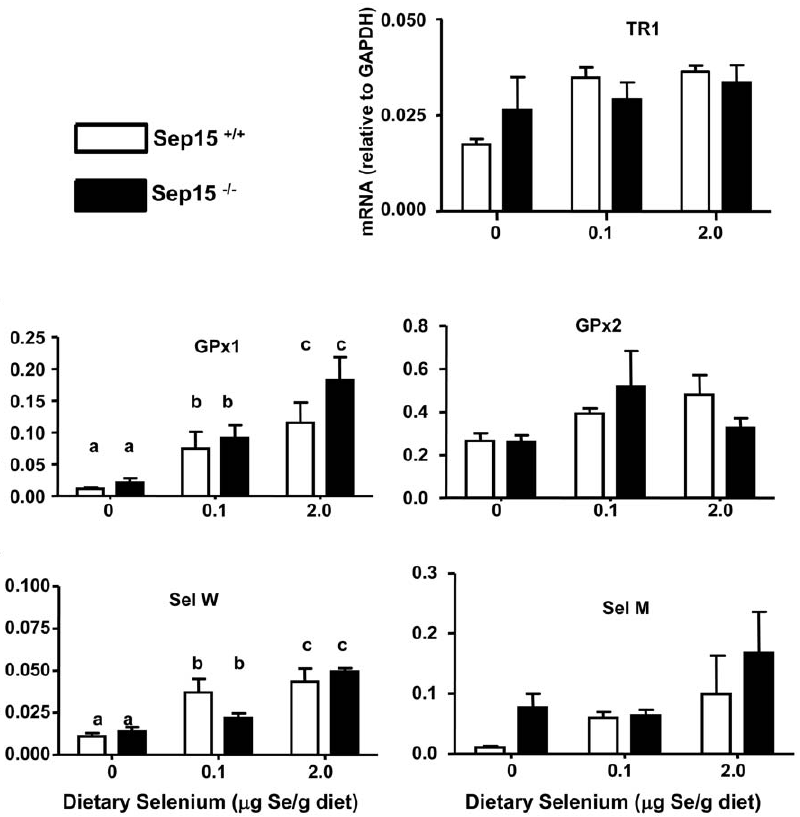
Figure 2. Analysis of selenoprotein mRNA expression in colonic epithelia of wild type allelic (Sep15 + / + ) and Sep15 knockout (Sep15 2 / 2 ) mice. Mice were maintained on 0, 0.1 or 2.0 m g selenium/g diet and mRNA levels were measured using real-time RT-PCR. Values are means 6 SEM; N=4 per genotype per diet. Letters indicate statistically significant differences (two-way ANOVA).